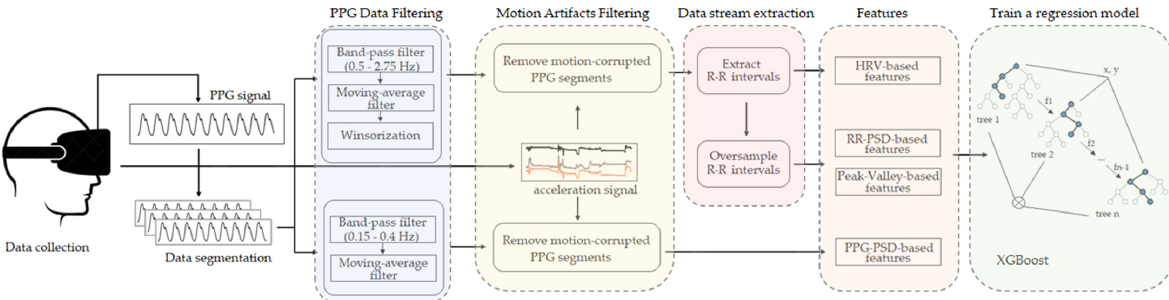
Figure 6. Block diagram of the proposed ML-based method for breathing rate estimation from PPG data acquired from a head-mounted device (VR headset).